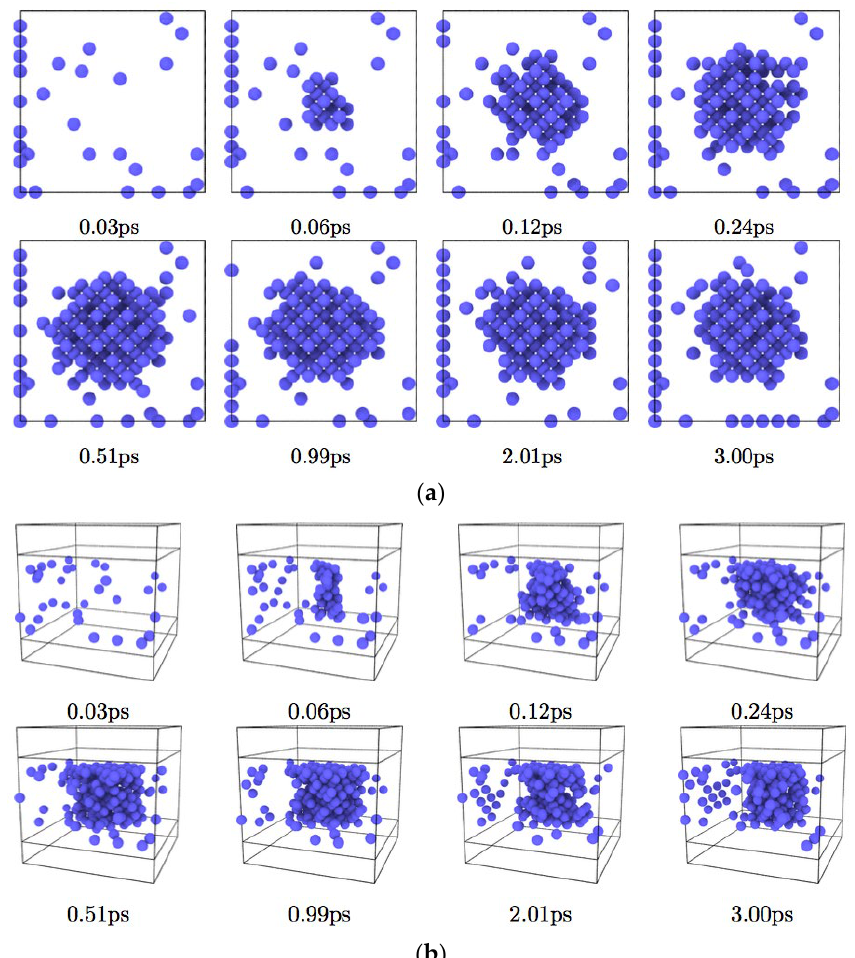
Figure 7. Distributions of vacancies in the CeO 2 systems viewed from ( a ) <001> and ( b ) <100> directions for the values of gSe = 0.8 keV/nm.